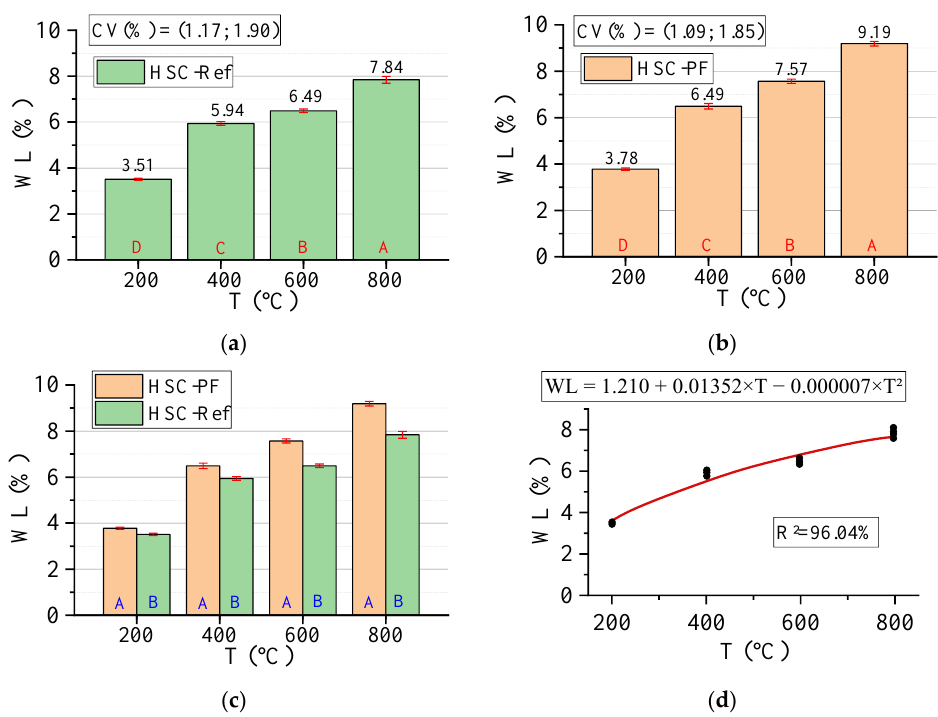
17 of 26 Figure 15. Quadratic multiple regression model fitting for electrical resistivity estimation. Based on the results of Equation (8), it is noted that the combination of two factors ended up reducing, even if only slightly, the coefficient of determination value, when compared to the quadratic model, depending only on temperature (Figure 14d). There-